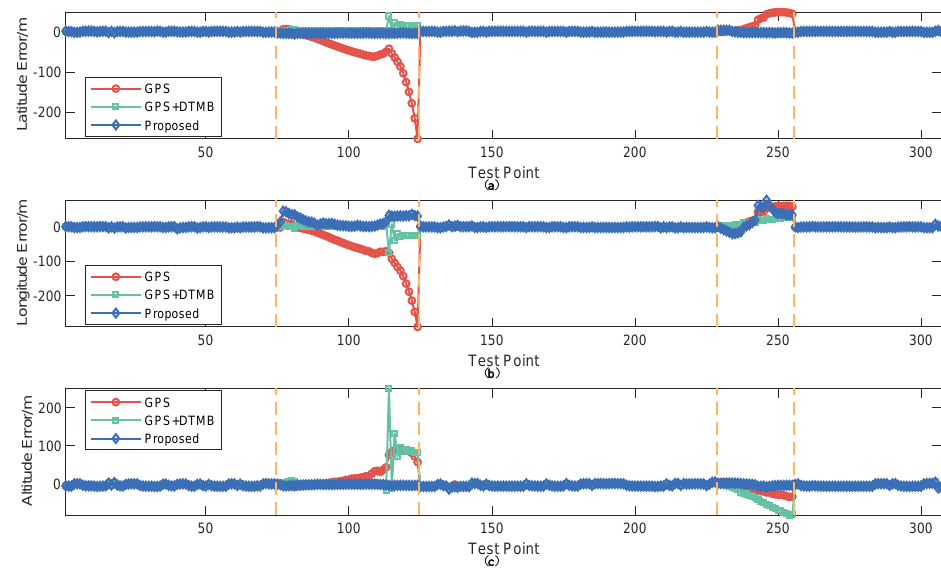
Figure 22. Positioning error of each point in latitude/longitude/altitude direction at Site 2: ( a ) error in latitude direction; ( b ) error in longitude direction; and ( c ) error in altitude direction.